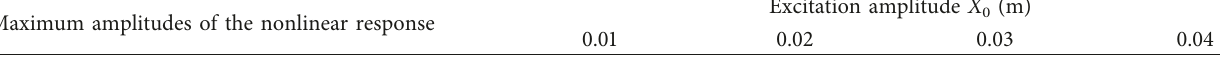
Table 5: The maximum amplitudes of the nonlinear response versus the excitation amplitude for r